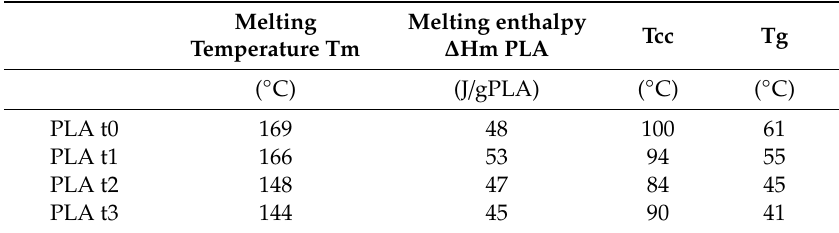
Table 4. DSC results for neat PLA during composting process at 58 ◦ C.